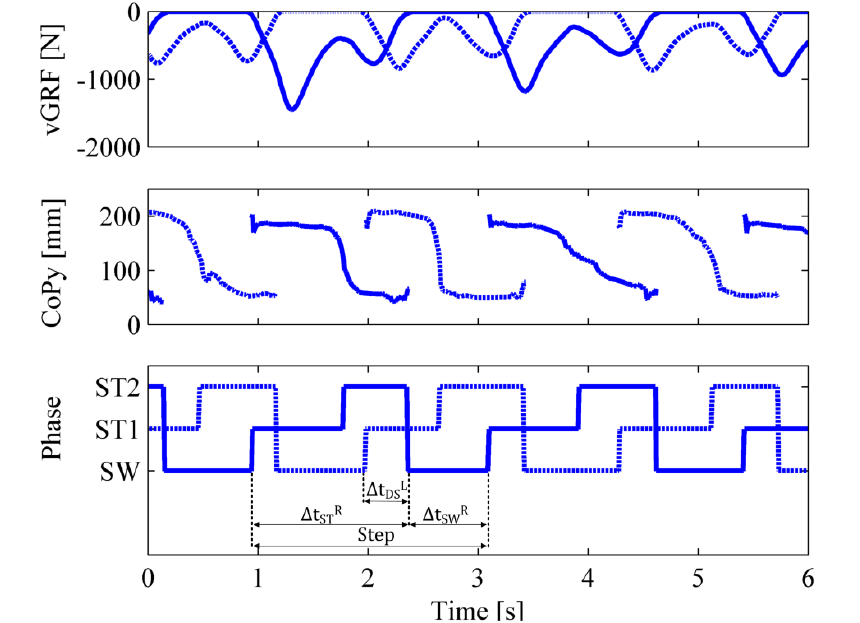
Figure 6. Extraction of temporal gait parameters. The top and mid panel depict the gait parameters ( and respectively) acquired from the right (solid blue line) and left (dotted blue line) pressure-sensitive insole. The bottom panel shows the results of the online classification in gait phases and the use of these phases to calculate temporal gait parameters for the right ( , , ) and left ( , , )